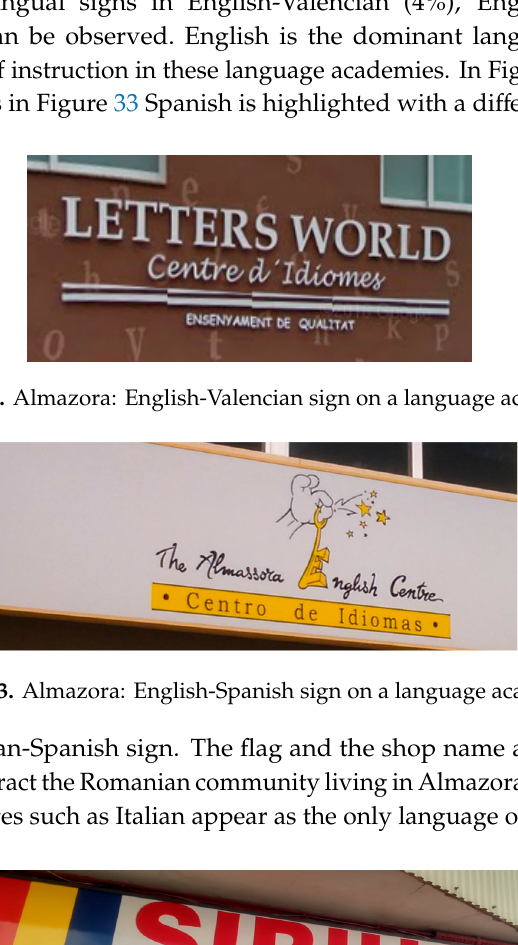
14 of 19 Figure 30. Almazora: Bilingual sign on a health food shop .